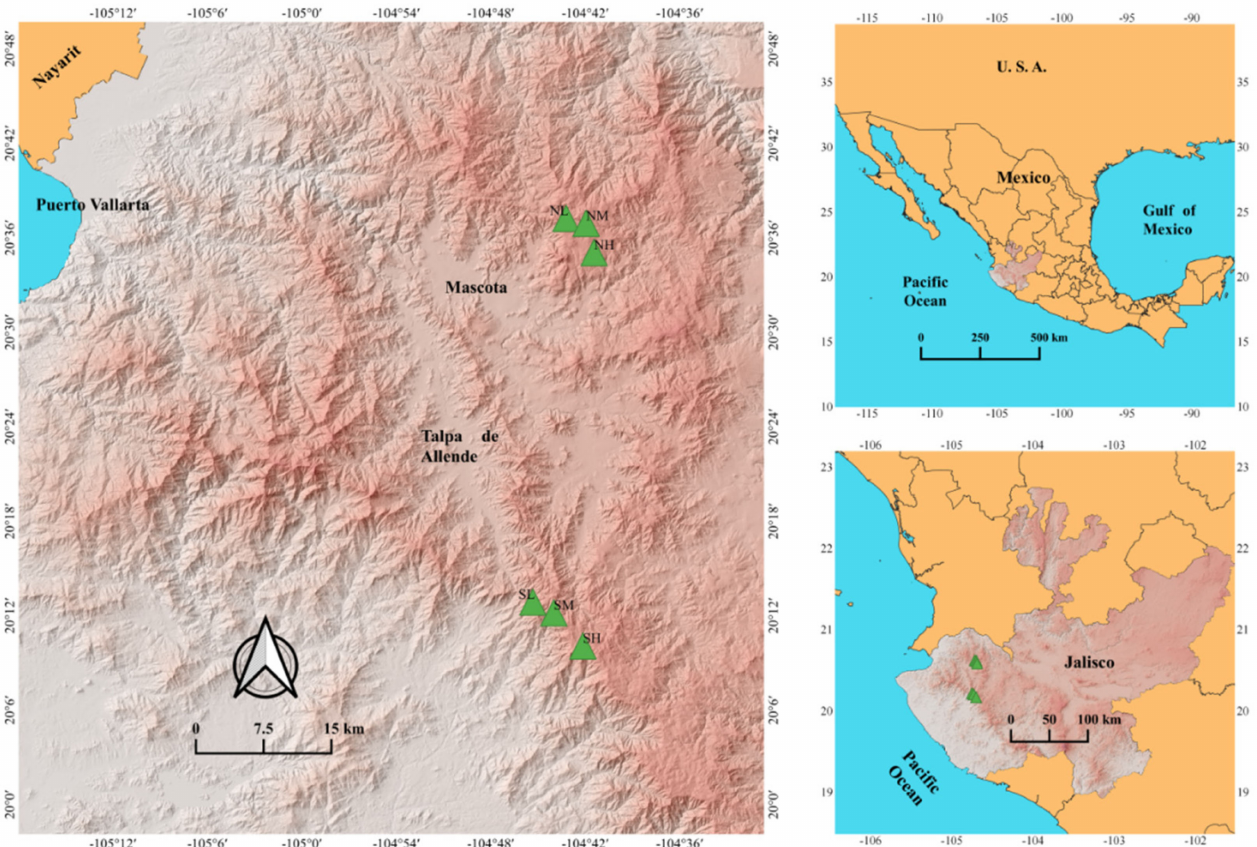
Figure 1. Location of the sampling sites in the mountains of western Jalisco, Mexico. NL, low- elevation north aspect; NM, mid-elevation north aspect; NH, high-elevation north aspect; SL, low- elevation south aspect; SM, mid-elevation south aspect; SH, high-elevation